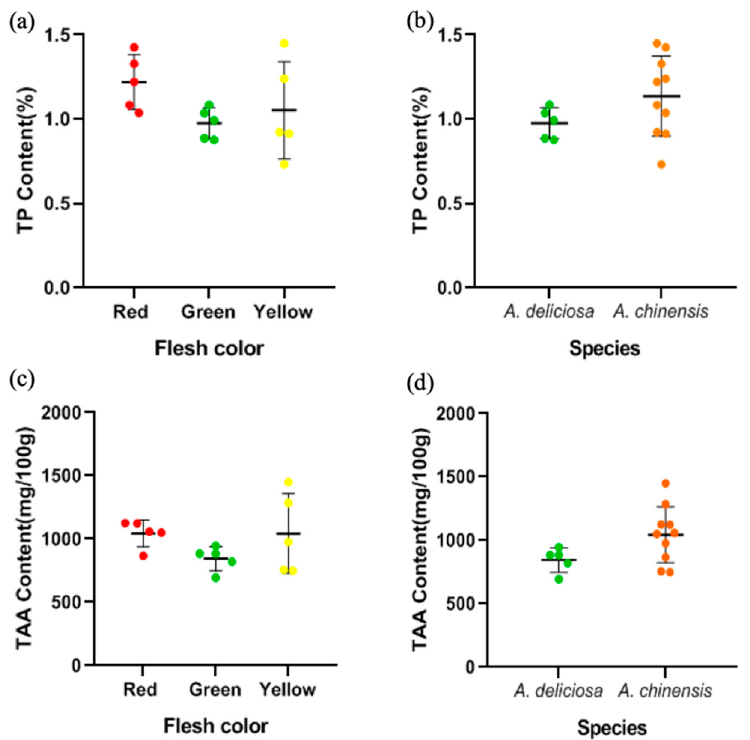
Figure 6. The distribution of TP content ( a ) in different flesh colors and ( b ) in the two species. The distribution of TAA content ( c ) in different flesh colors and ( d ) in the two species.